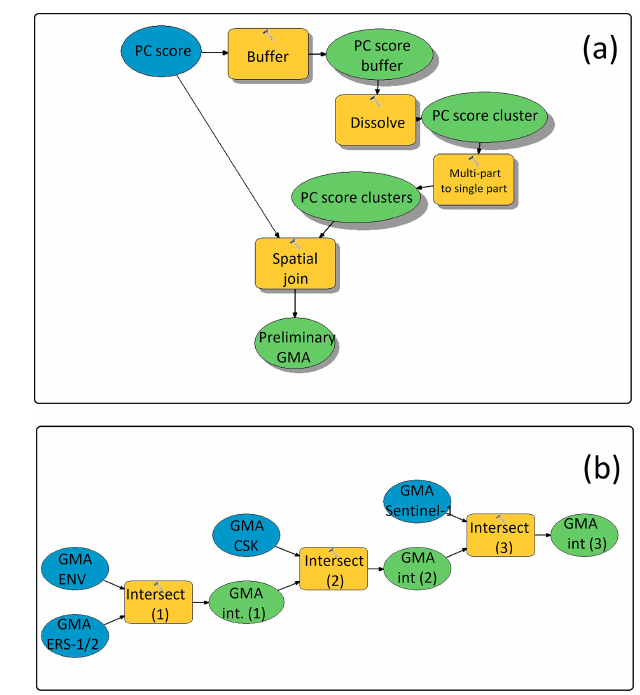
Figure 3. Geoprocessing workflow of the GMA-D and PGMA-D models which allow to create preliminary GMA (a) and persistent GMA (b) ,